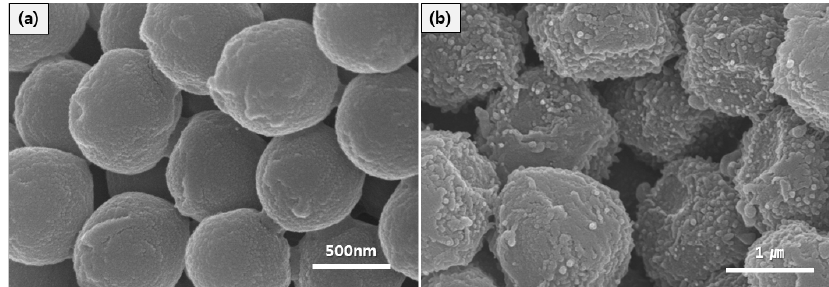
Figure 2. Scanning electron microscopy (SEM) images of ( a ) pure PMMA seeds and ( b ) PMMA-PNMA particles.